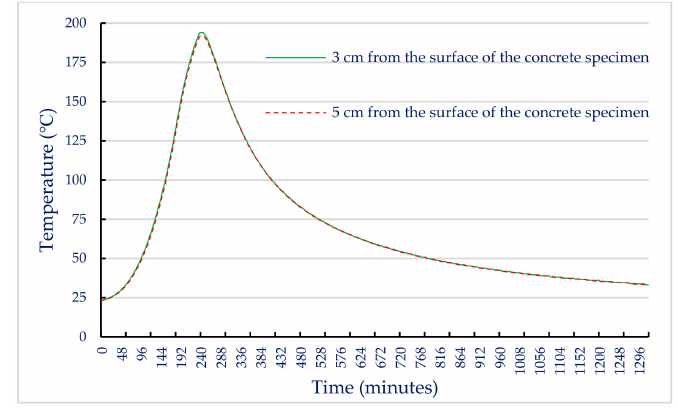
Figure 8. Relationship between specimen internal temperature and time (target temperature = 400 ◦ C).